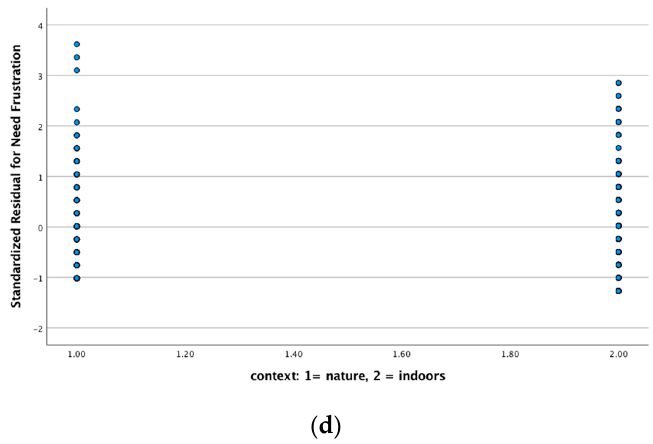
Figure A1. Q–Q Plots of the Standardized Residuals, and Scatter Plots of the Variation of Standardized Residuals for the Two Contexts. ( a ) Q–Q Plot of the Standardized Residuals for Need Satisfaction. ( b ) Q–Q Plot of the Standardized Residuals for Need Frustration. ( c ) Scatter Plot of the Variation of Standardized Residuals for Need Satisfaction per context. ( d ) Scatter Plot of the Variation of Standardized Residuals for Need Frustration per context.